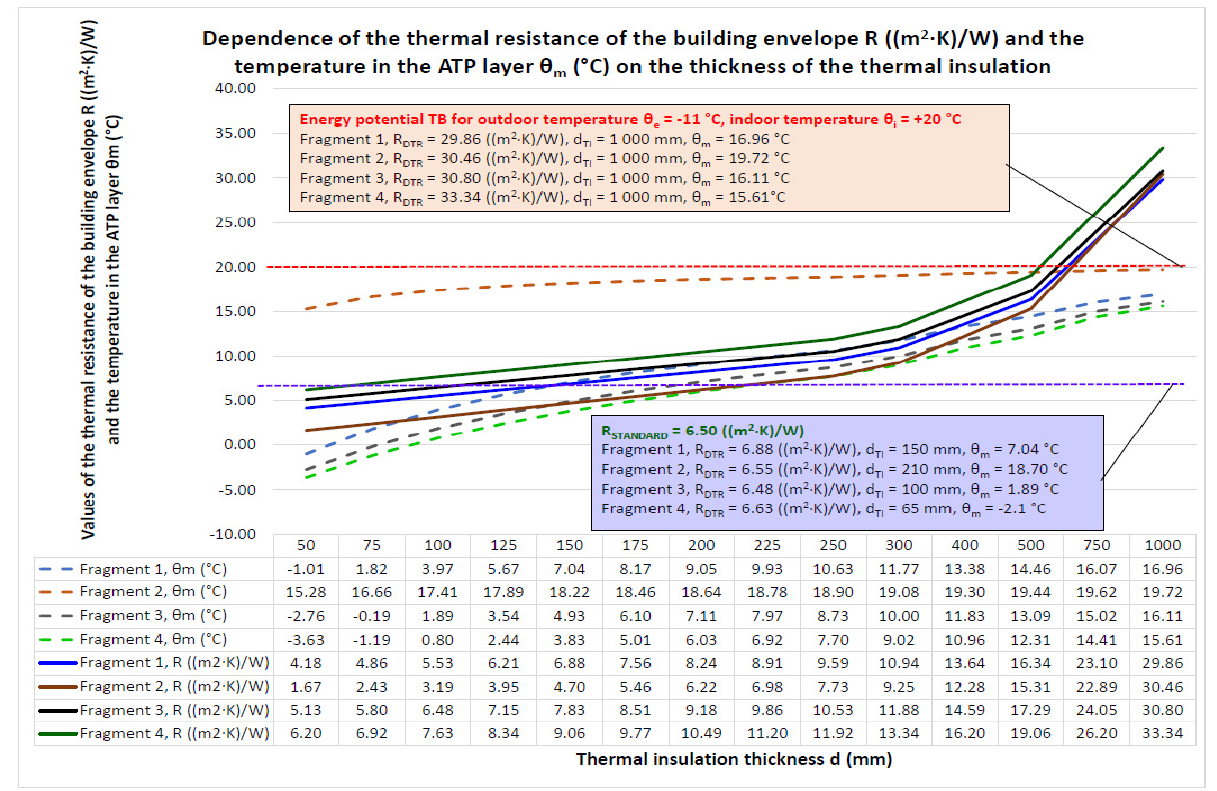
Figure 39. The graphical dependencies of the dynamic thermal resistance R DTR ((m 2 ·K)/W) on the thickness of the static/dynamic thermal insulation and the mean temperature of the heat transfer medium in the ATP tubes θ m (°C) for all fragments investigated.